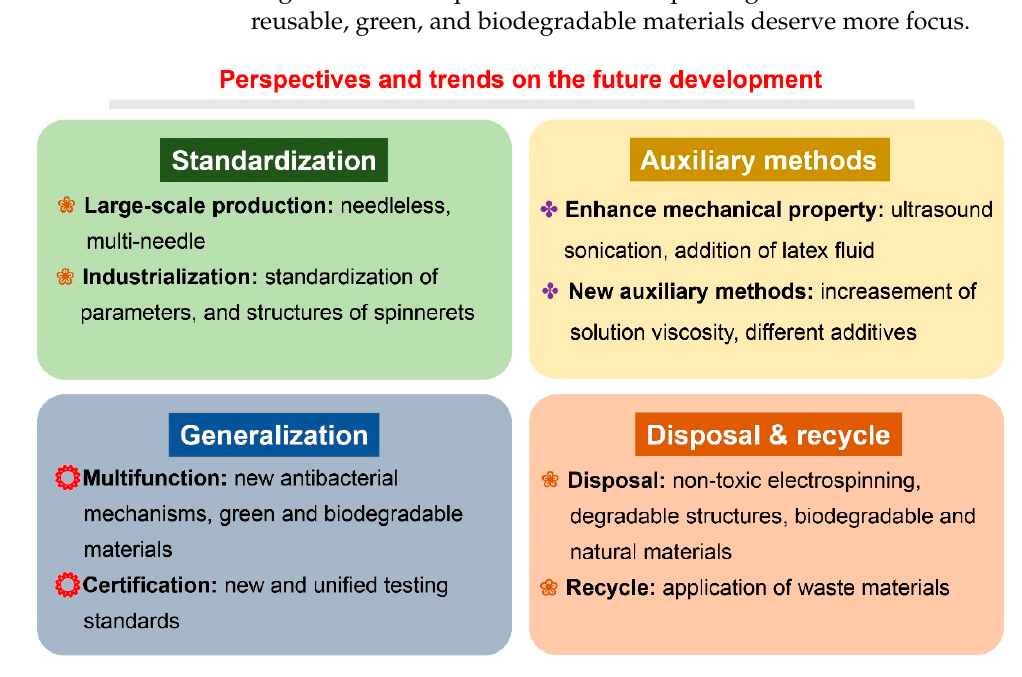
Figure 14. Perspectives and trends on the future development of electrospinning techniques and nanofibrous air filtration membranes.